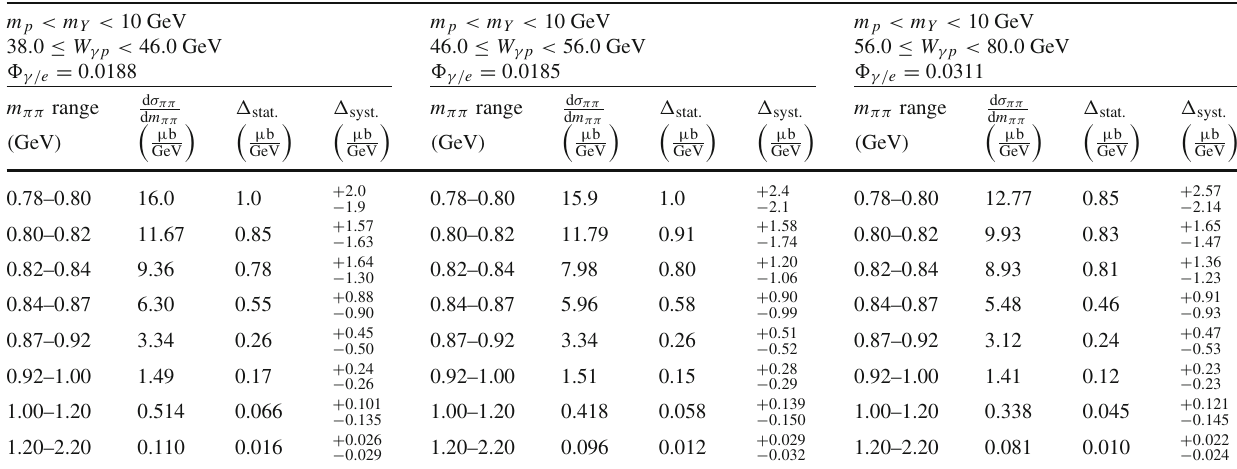
systematicuncertaintiesincludingnormalisationuncertaintiesaregiven by (cid:20) stat. and (cid:20) syst. , respectively. A full uncertainty breakdown and sta- tistical correlations are provided [77]. The data are shown in Fig.